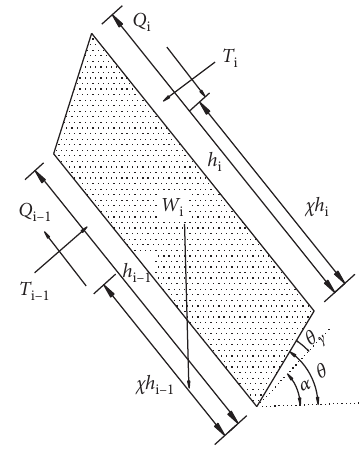
Figure 3: Force analysis chart of stratum i for tension